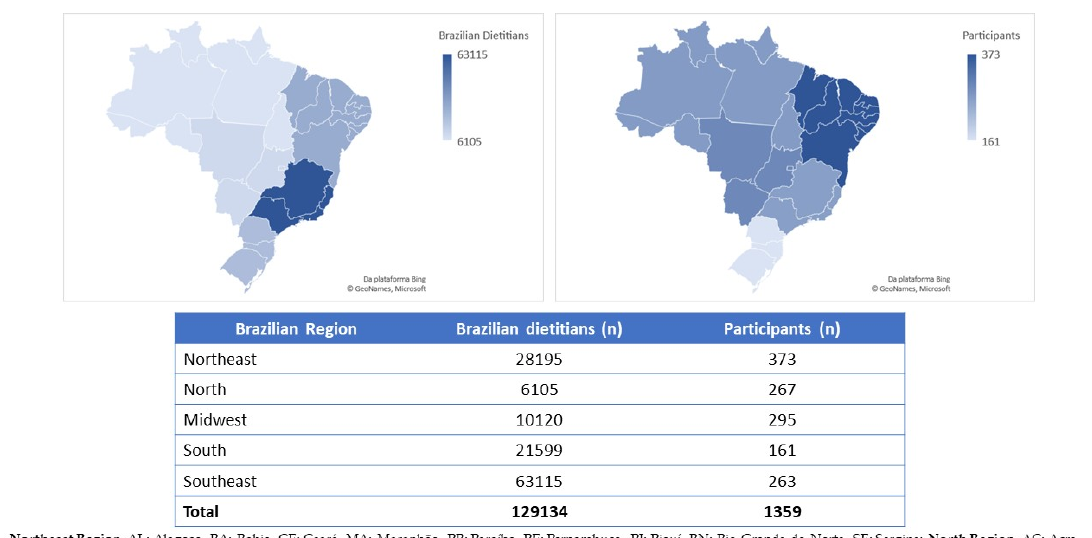
Figure 1. Distribution of dietitians and participants among Brazilian regions.